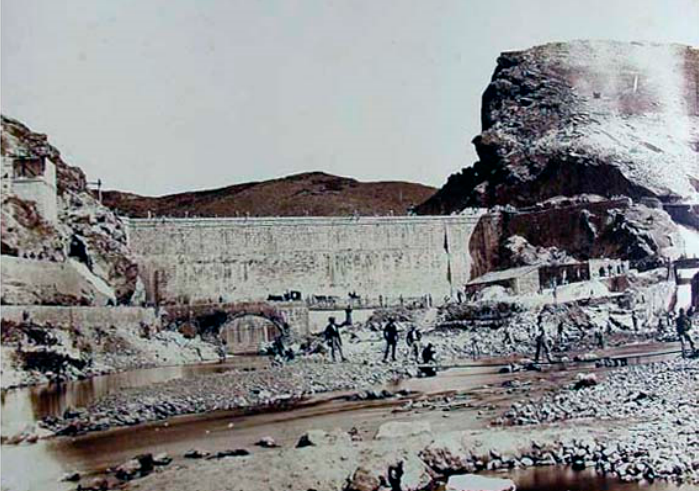
Figure 2. Construction of the Pontón de la Oliva dam, 1855. Photo: Charles Clifford. (Public domain. Biblioteca virtual del Patrimonio Bibliográfico, https://bvpb.mcu.es/es/consulta/registro.cmd?id=403102) (accessed on 15 May 2022).